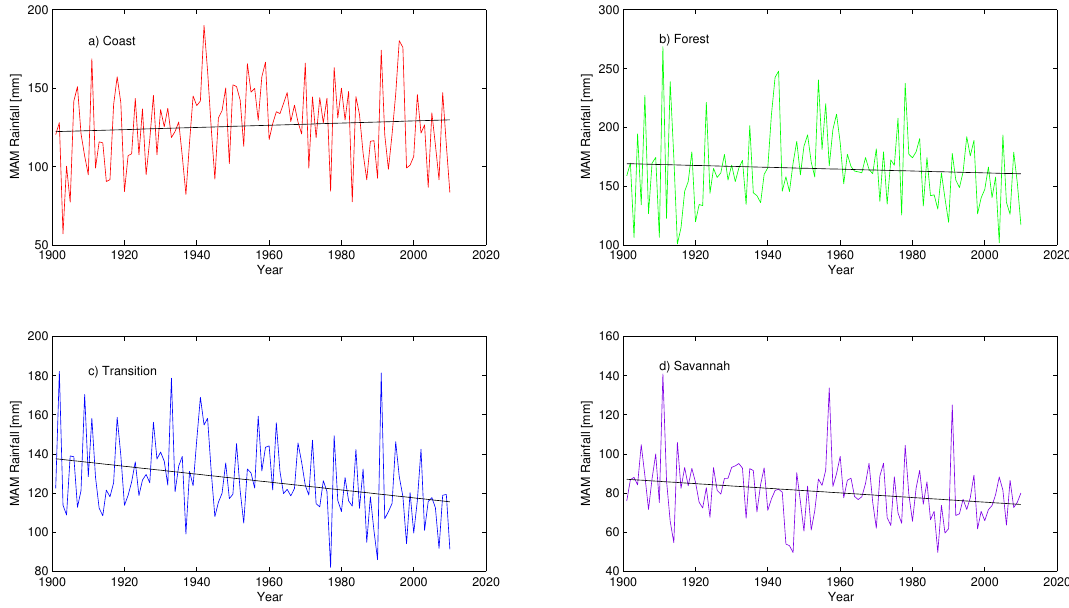
Figure 14. ( a – d ) Long-term course of seasonal rainfall over the agro-ecological zones of Ghana for